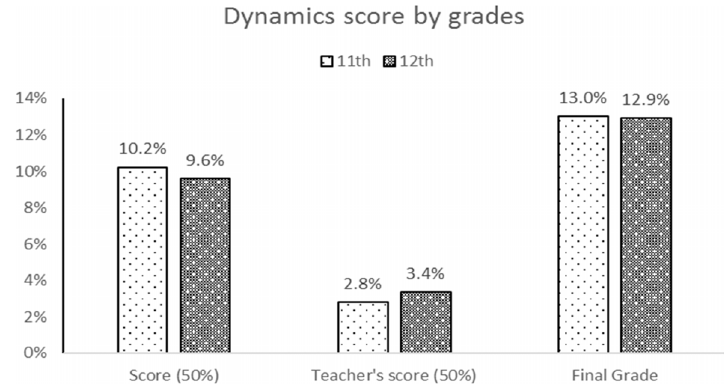
Fig. 1 Relative dynamics of the post-app period and the pre-app period by grade